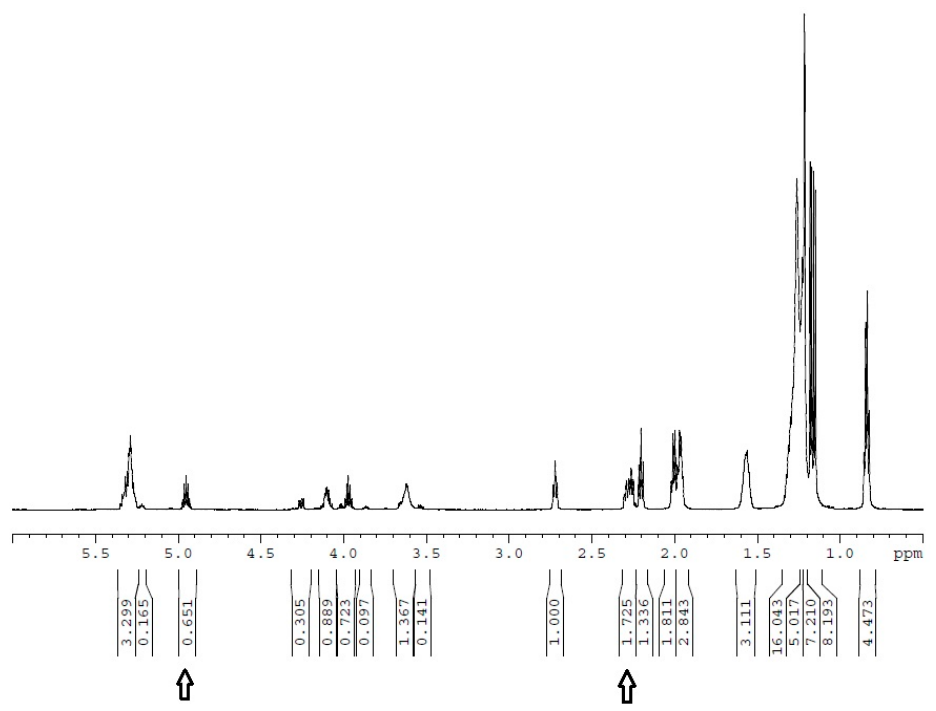
Figure 4. NMR spectrum of esterified JO for the case at T E = 374.8 K with m O = 200 g, M IOE = 5, M H/HO = 0.94 wt.%, Q IPA/H = 1.5 mL/min, and t E = 58.5 min. P UI = 420 W.